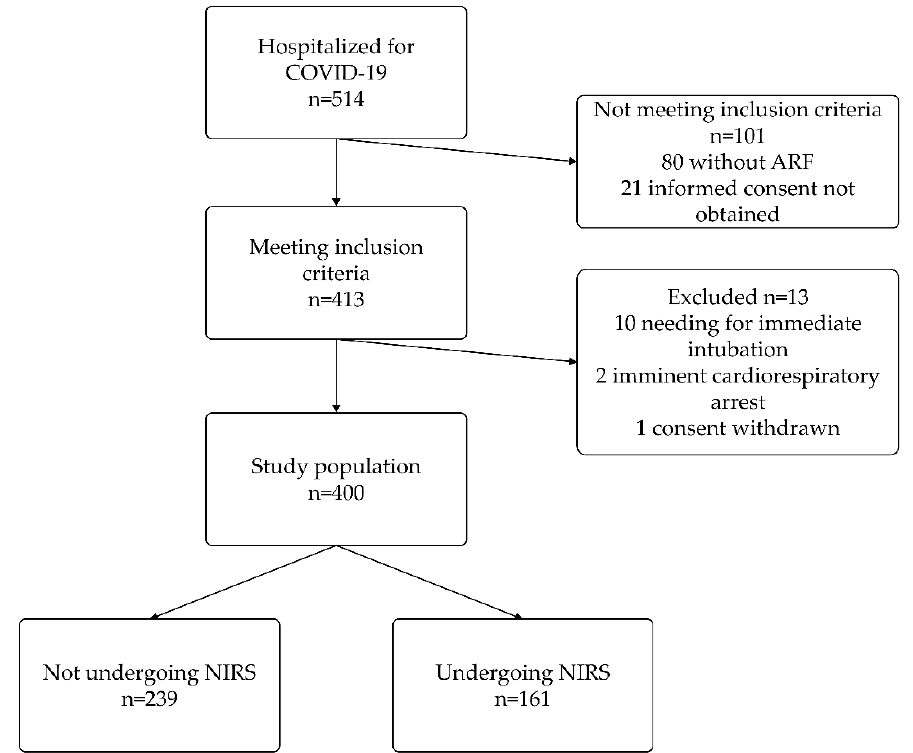
Figure 1. Flowchart of patients’ enrollment and NIRS use. ARF, acute respiratory failure; NIRS, non - invasive respiratory